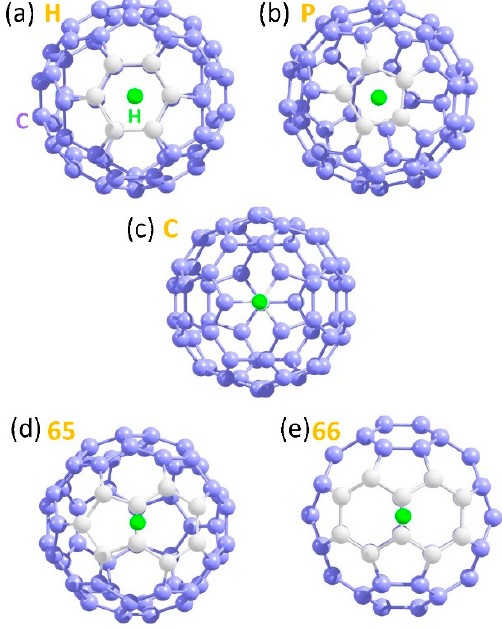
Figure 1. Initial configurations of a single hydrogen atom adsorbed on five different sites on the surface of pristine C 60 .